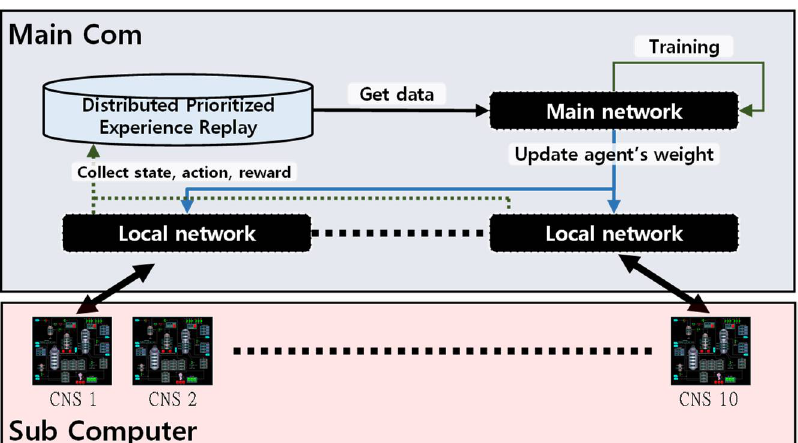
Figure 11. Multi-CNS environment for training and validating the developed DRL-based controller.